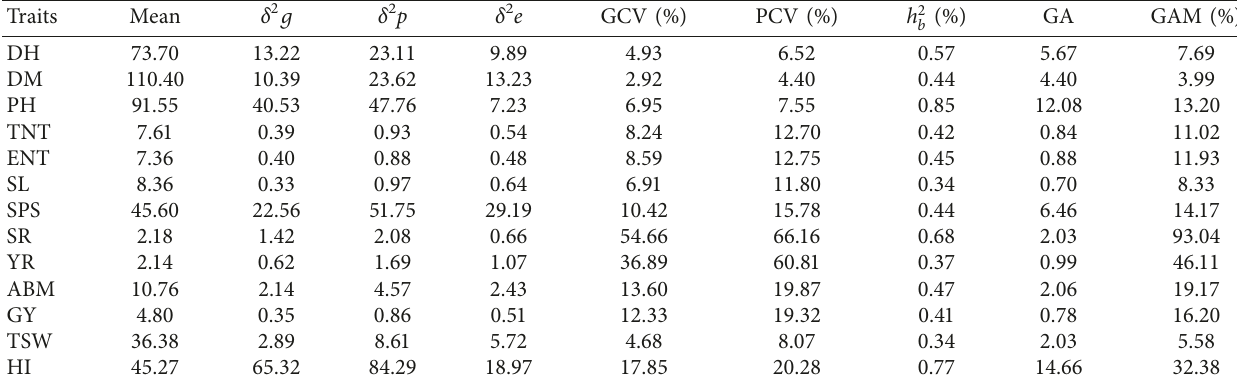
Table 9: Estimates of variance components at Damot Gale experimental site. Traits